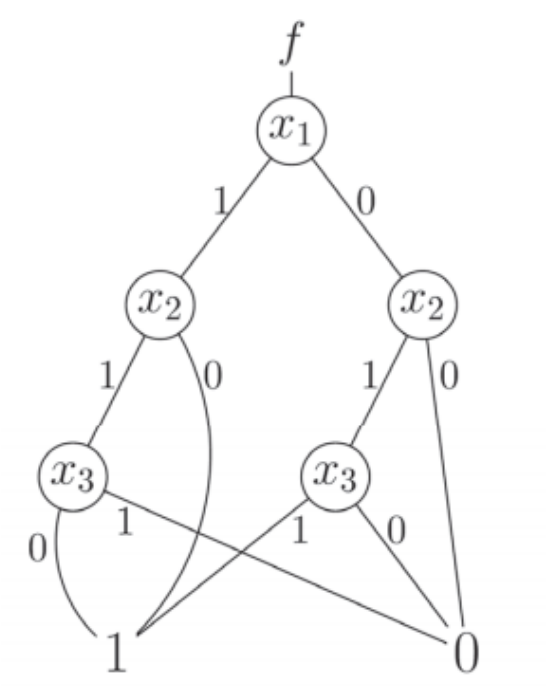
Figure 3. Binary Decision Diagram (BDD) representation of the Boolean function f = x 1 ⊕ x 2 · x 3